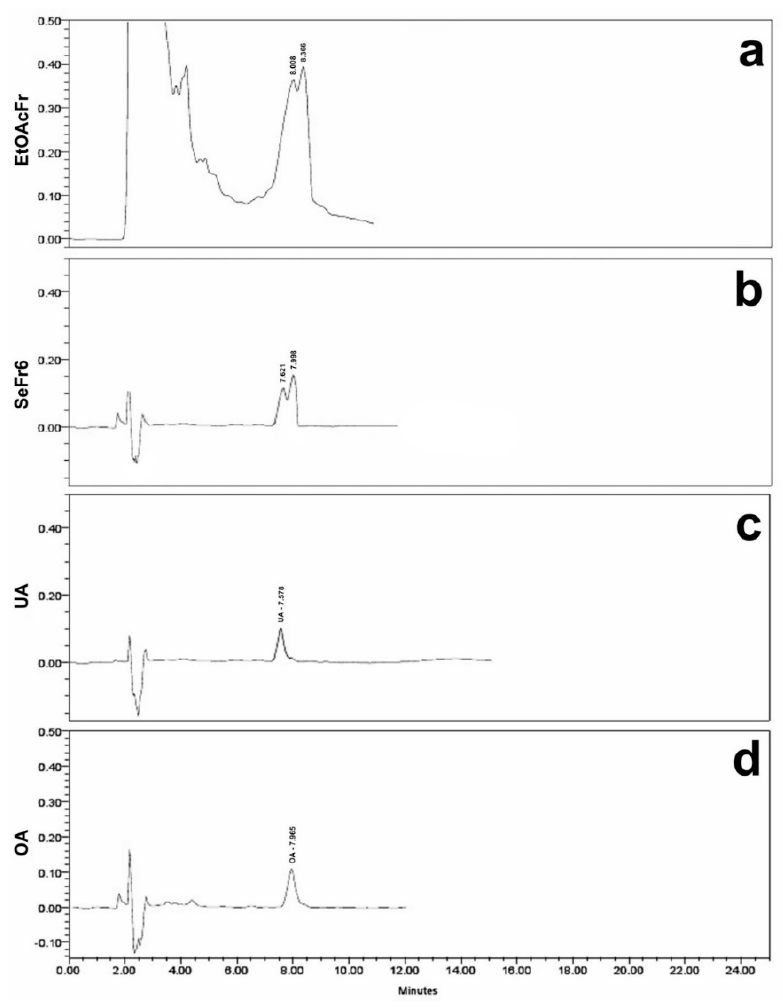
Figure 1. HPLC-DAD chromatograms of EtOAcFr ( a ), SeFr6 ( b ), UA ( c ) and OA ( d ) standard. The compounds identified, UA and OA, were evaluated in diabetic mice (Table 2). OA significantly decreased the blood glucose levels after 90 min, until 120 min. In the case of UA, this compound significantly decreased blood glucose levels after 30 min, until 120 min; this effect was similar to